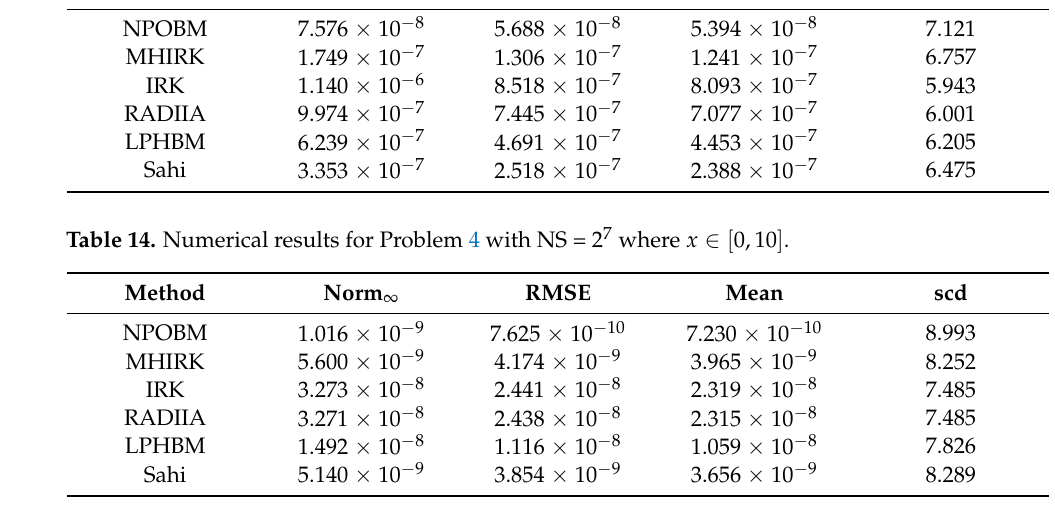
Table 13. Numerical results for Problem 4 with NS = 2 6 where x ∈ [ 0,10 ] . Method